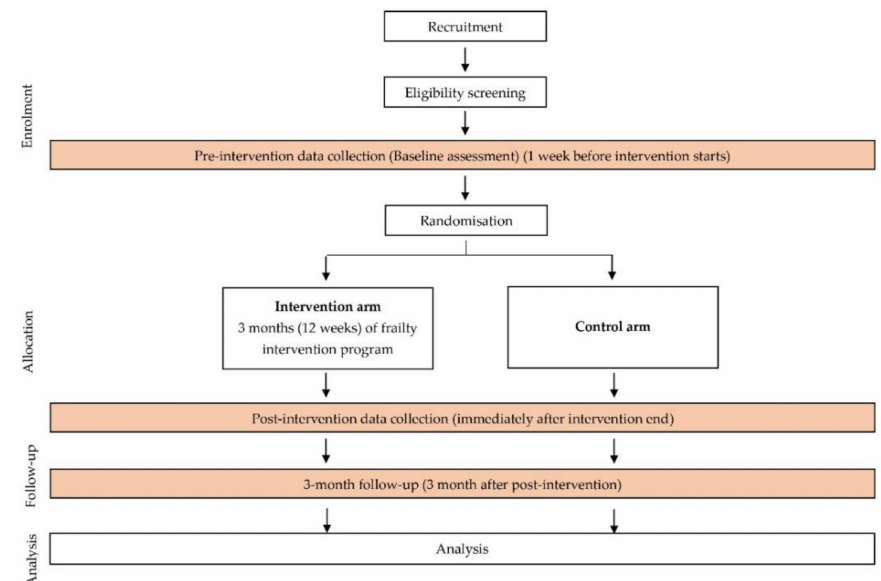
Figure 1. The overview of the frailty intervention study flow. Adapted from the CONSORT 2010 flow diagram (extension to cluster randomized trails)